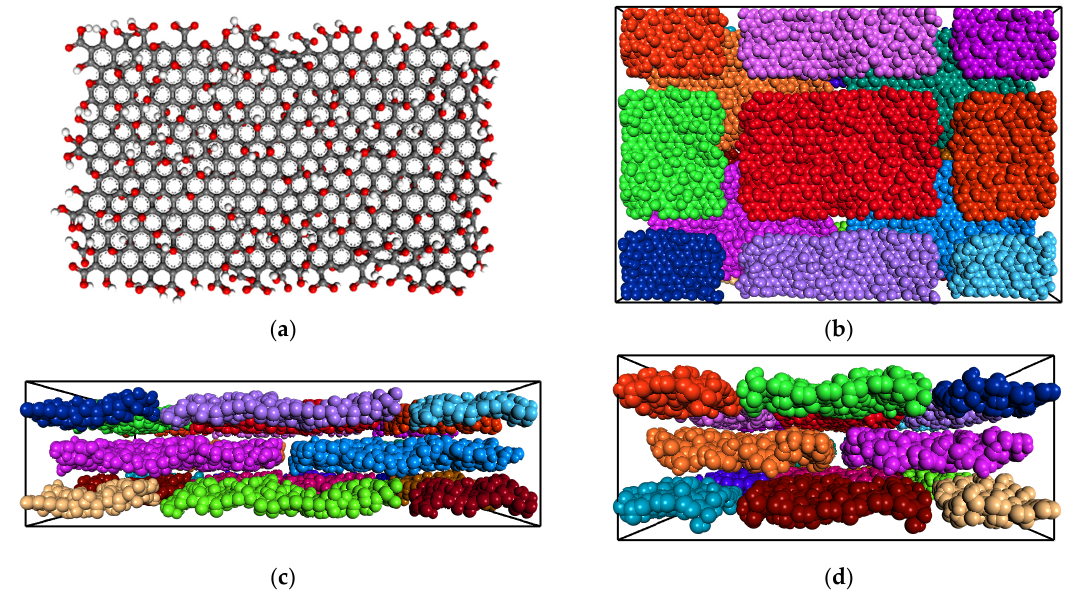
Figure 2. ( a ) GO layer structure. ( b ) Top view of GO box containing 3 layers of GO, each comprising 4 sheets. ( c ) Long and ( d ) short side view of the GO layers. In panels ( b – d ), each sheet is colored differently to make it easy to understand their spatial organization. Atoms are pictured with respect to their van der Waals